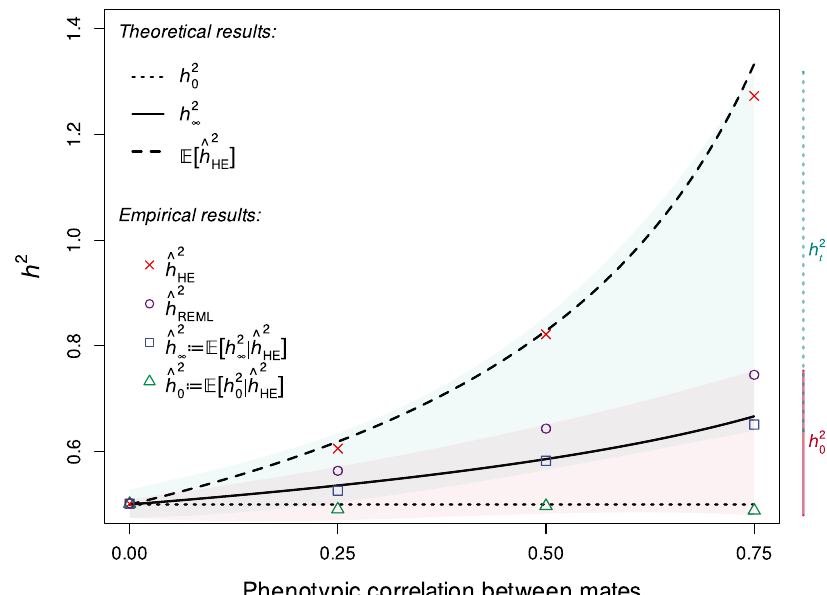
) and REML ( ^ h 2 ) estimates for varying phenotypic HE REML ¼ : 5, that all causal variants are measured, and that AM has reached 0 (cid:6) ) under the assumption of exchangeable loci. Our corrected HE ) and panmictic ( h 2 ) heritabilities. Further, for 1 0 are probabilistically bounded in expectation 0